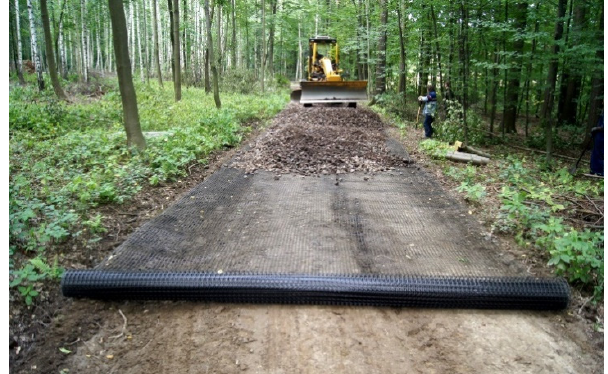
Figure 10. A test of the geogrid ʹ s suitability for separating aggregate from the subsoil. Effect: saving 20% of aggregate during construction of the forest fire roads (Photo: A. Czerniak).